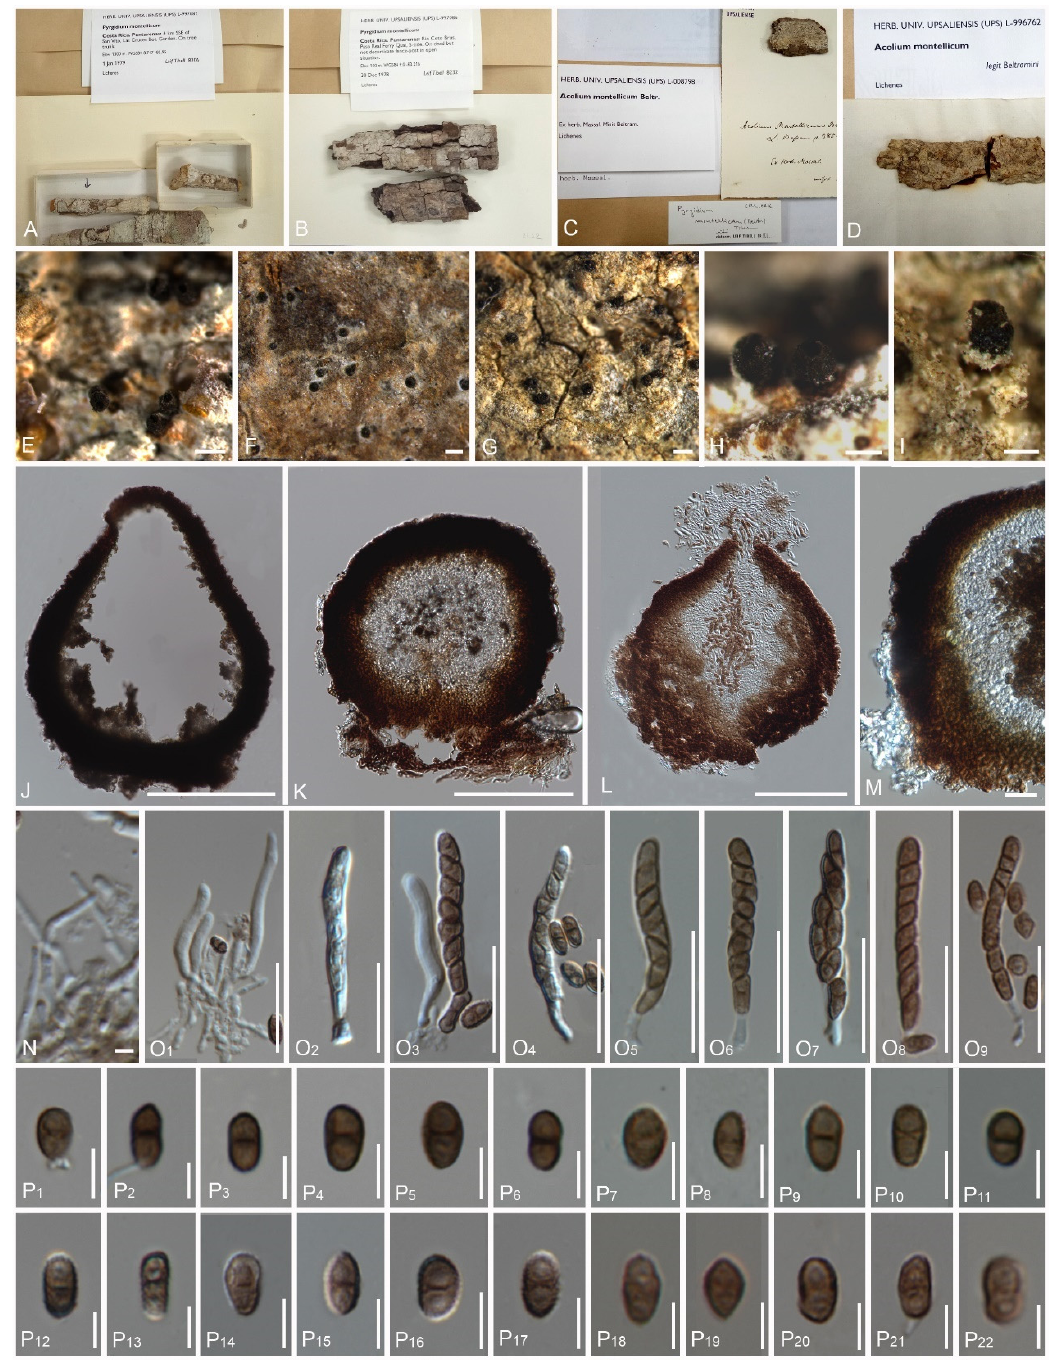
Figure 4. Pyrgidium montellicum (type materials of Acolium montellicum (L-008798, L-996762) and non-type materials of P. montellicum (Tibell 8306, Tibell 8232)), ( A – D ). Details of herbarium specimens ( A ). Tibell 8306, ( B ). Tibell 8232, ( C ). L-008798, ( D ). L-996762, ( E – I ). Ascomata on substrate ( E , H ). Tibell 8306, ( F ). Tibell 8232, ( G , I ). L-008798, ( J – L ). Vertical section through the exciple, ( J ). Tibell 8306, ( K ). Tibell 8232, ( L ). L-996762, ( M ). Tibell 8232, ( N ). L-996762, ( O 1 – O 9 ). Asci, ( O 1 – O 4 , O 7 ). L-996762, ( O 5 , O 6 ). L-008798, ( O 8 , O 9 ). Tibell 8232. Ascospores (( P 1 – P 22 ), ( P 1 – P 6 ). Tibell 8306, ( P 7 – P 8 ). L-008798, ( P 12 – P 16 ). 1981 L-996762, ( P 17 – P 22 ). Tibell 8232)). Scale bars: ( E , F ) = 1000 µm, ( G , H ) = 500 µm, ( J – L ) = 100 µm, ( M ) = 20 µm, ( K ) = 5 µm, ( O 1 – O 9 ) = 20 µm, ( P 1 – P 22 ) = 5 µm. Description of the type Acolium montellicum : Saprobic on bark. Thallus crustose, farinose and whitish. Prothallus absent. Photobiont with loosely associated algae, sparsely present in thallus, mostly trentepohlioid or absent. Sexual morph: Ascomata scattered, apothecial, rarely urn-